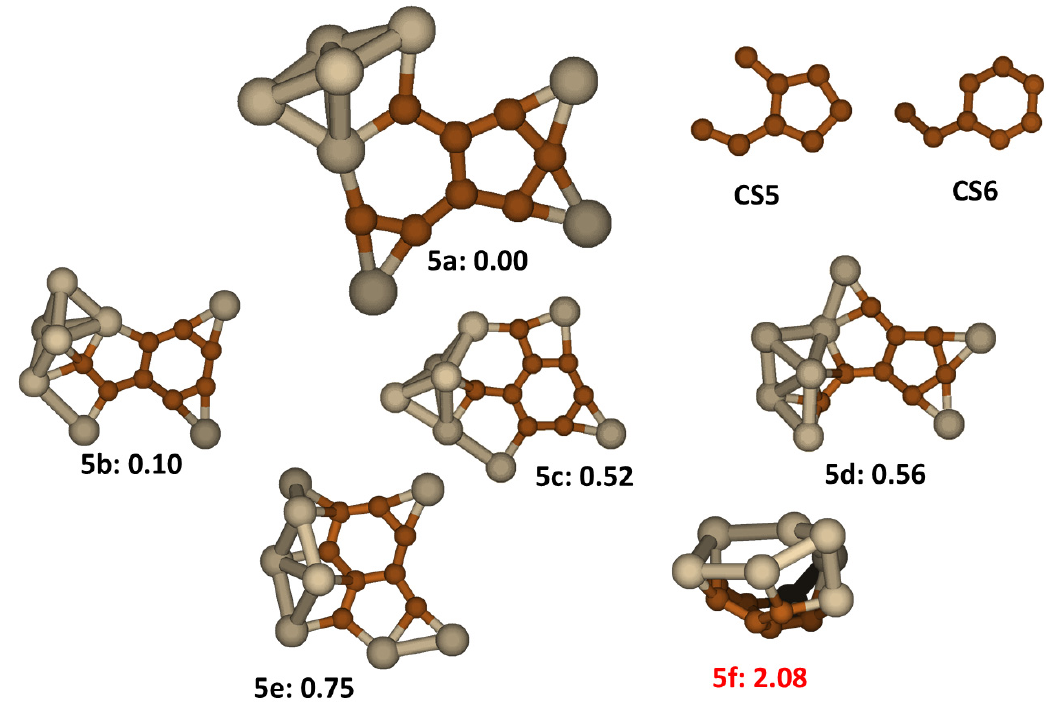
Figure 5. The structures and relative energies (in eV) of the lower energy Si Structure 5f is previously reported in ref.